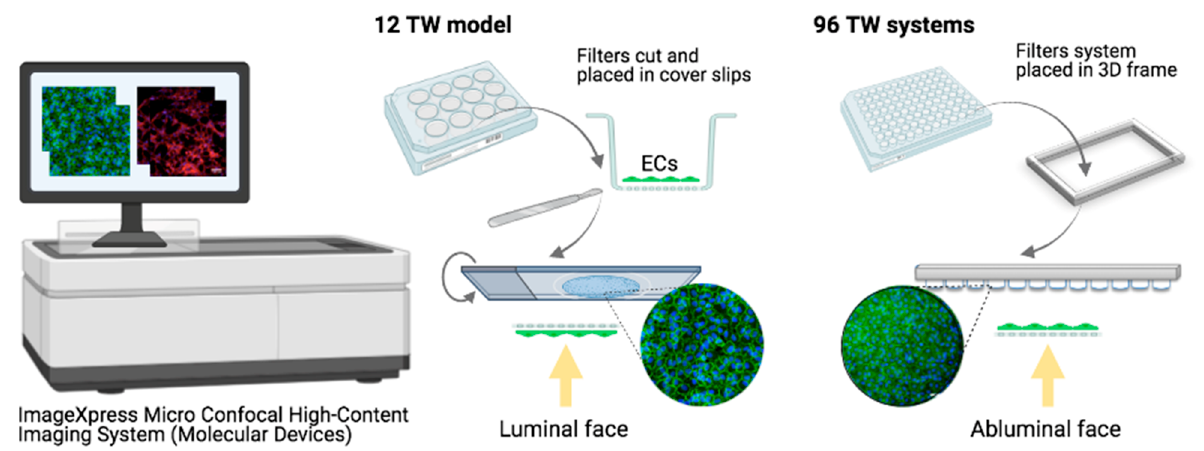
Figure 3. Schematic representation of endothelial cell visualization by confocal microscopy. In the original 12 TW model, filters were cut and placed in coverslips, then returned to acquire the pictures over the luminal faces of the ECs. Where filters from the miniaturized systems were directly placed on a 3D frame developed and adapted to the microscope, avoiding the need of the bottom compartment, reducing the lens height of going through the two compartments, pictures were taken from the abluminal EC face by going through the filter. Image created with BioRender.com (accessed on 15 April